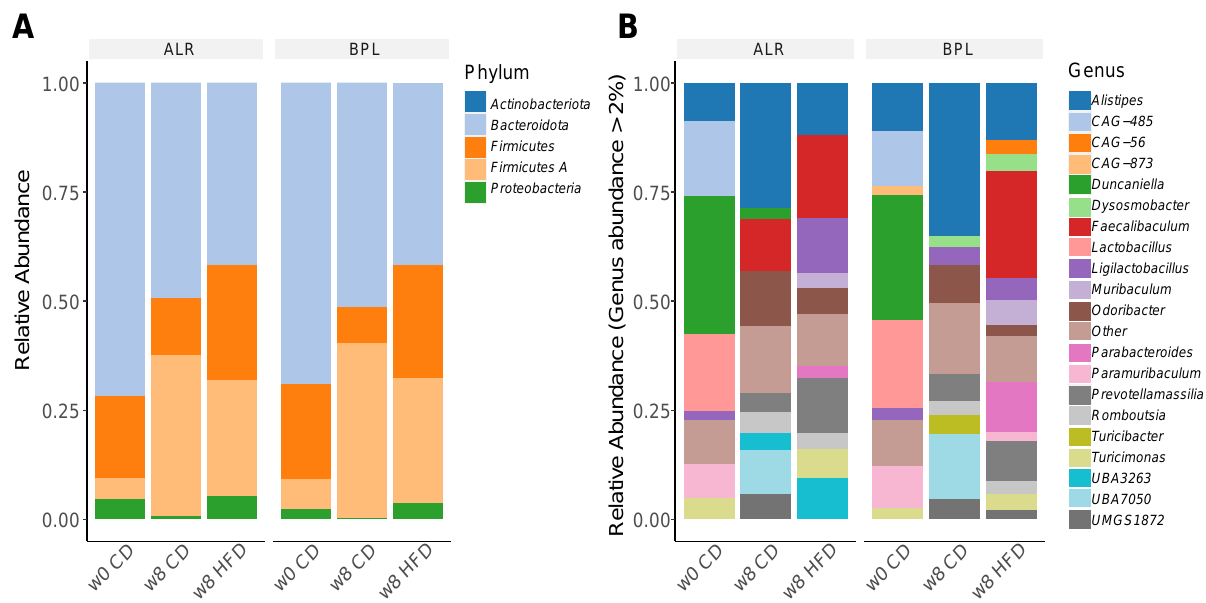
Figure 2. Relative taxonomic abundance comparison between B6-mt BPL and B6-mt ALR mice with dif- ferent diet groups at the phylum level ( A ) and at the genus level ( B ) BPL = B6-mt BPL , ALR = B6-mt ALR , w0 = week 0, w8 = week 8, CD = control diet, HFD = high fat